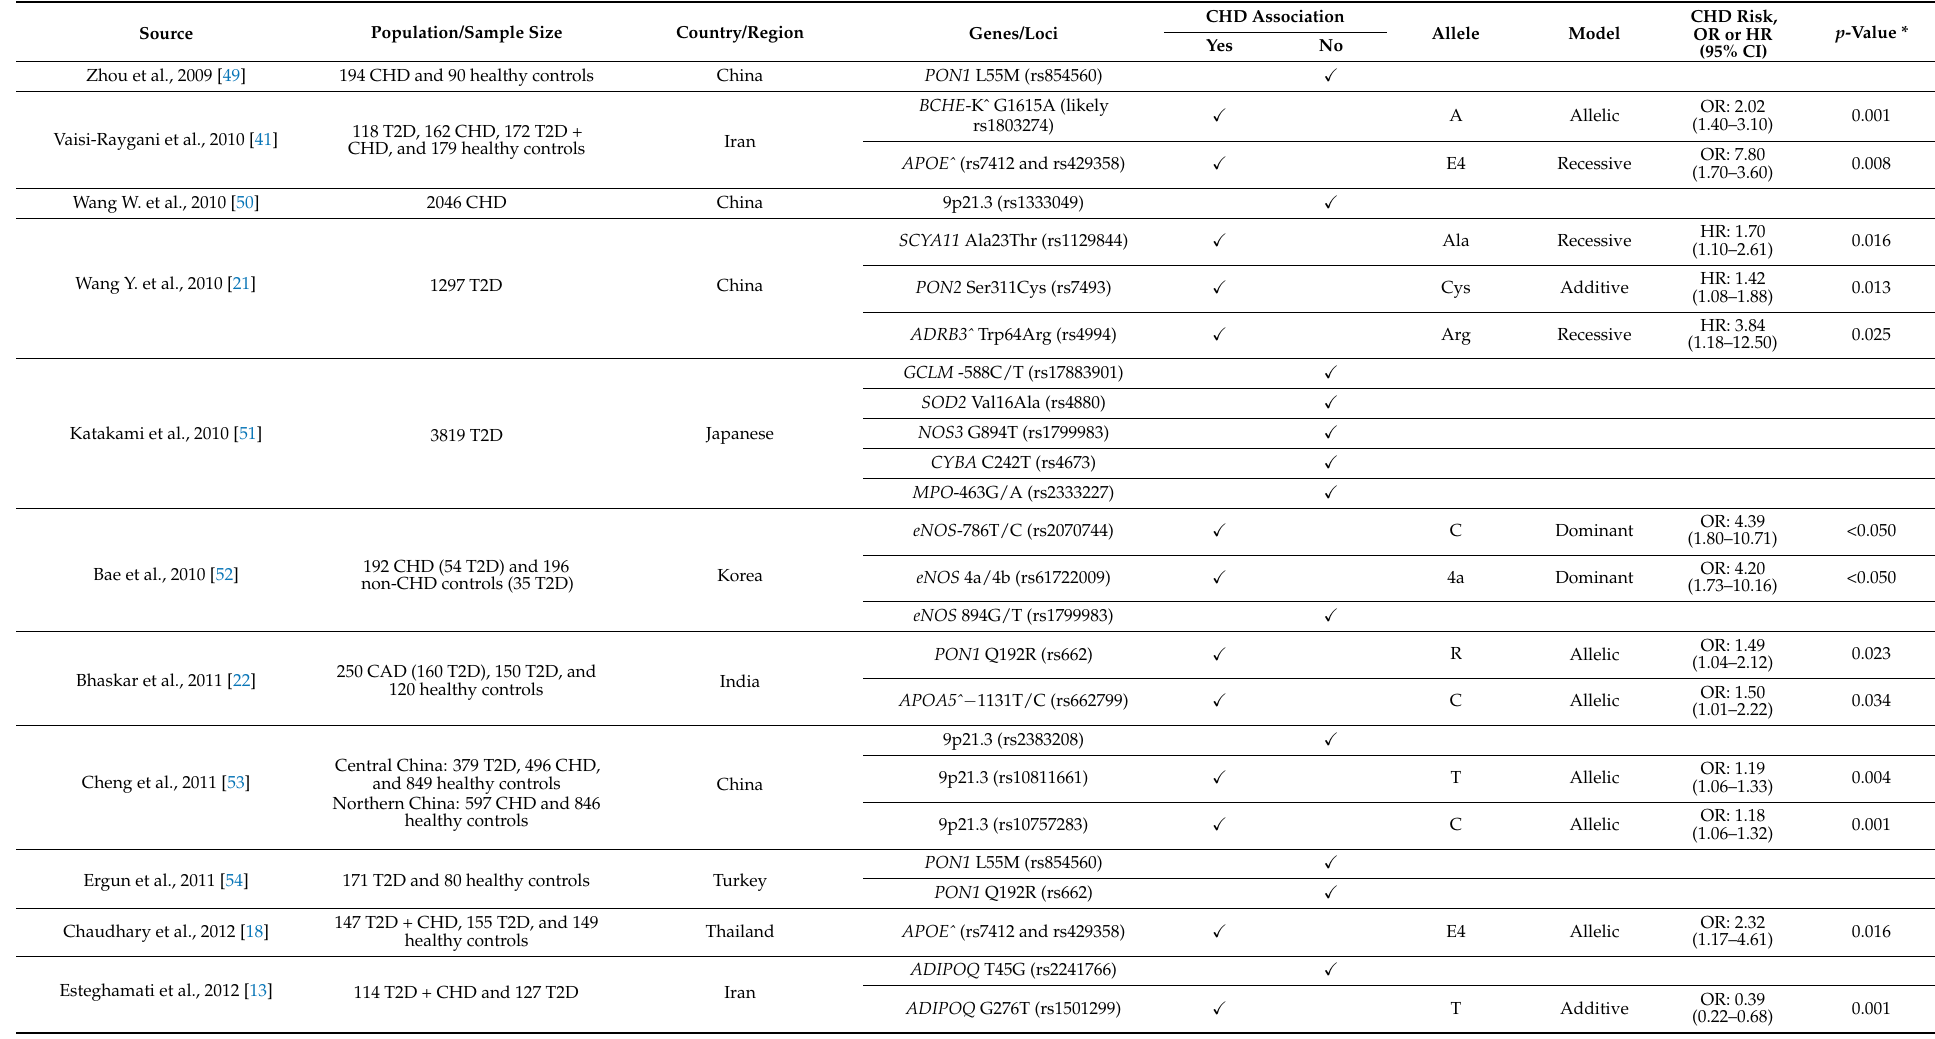
Table 1. Genetic factors associated with coronary heart disease in type 2 diabetic Asian